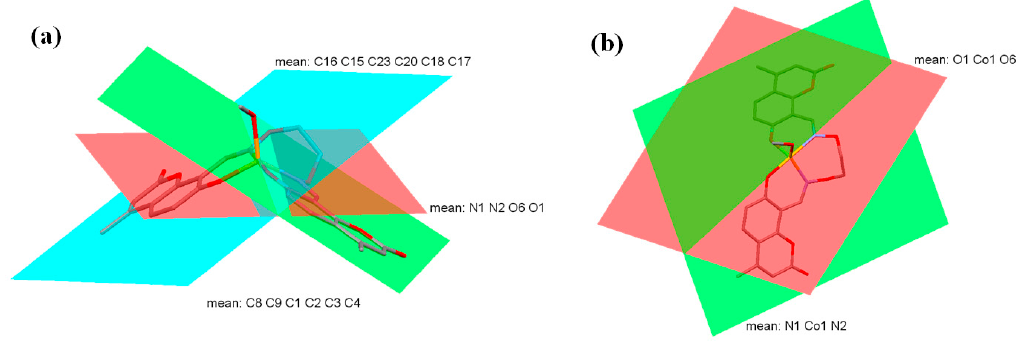
Figure 8. ( a ) View of the dihedral angles between the benzene rings and the N 2 O 2 basal plane of complex 2 ; ( b ) View of the dihedral angles between the planes CoN 2 and CoO 2 of complex 2 .